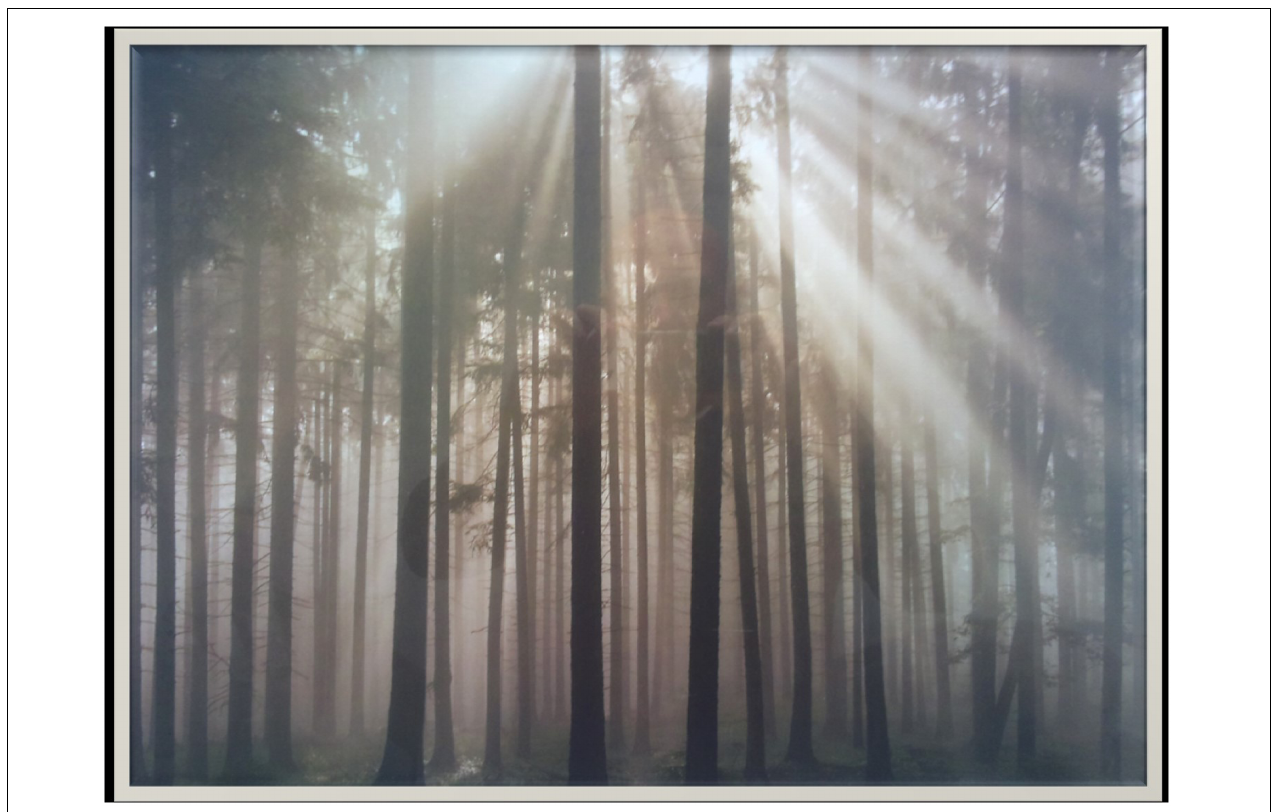
FIGURE 1 | The picture of the wooden